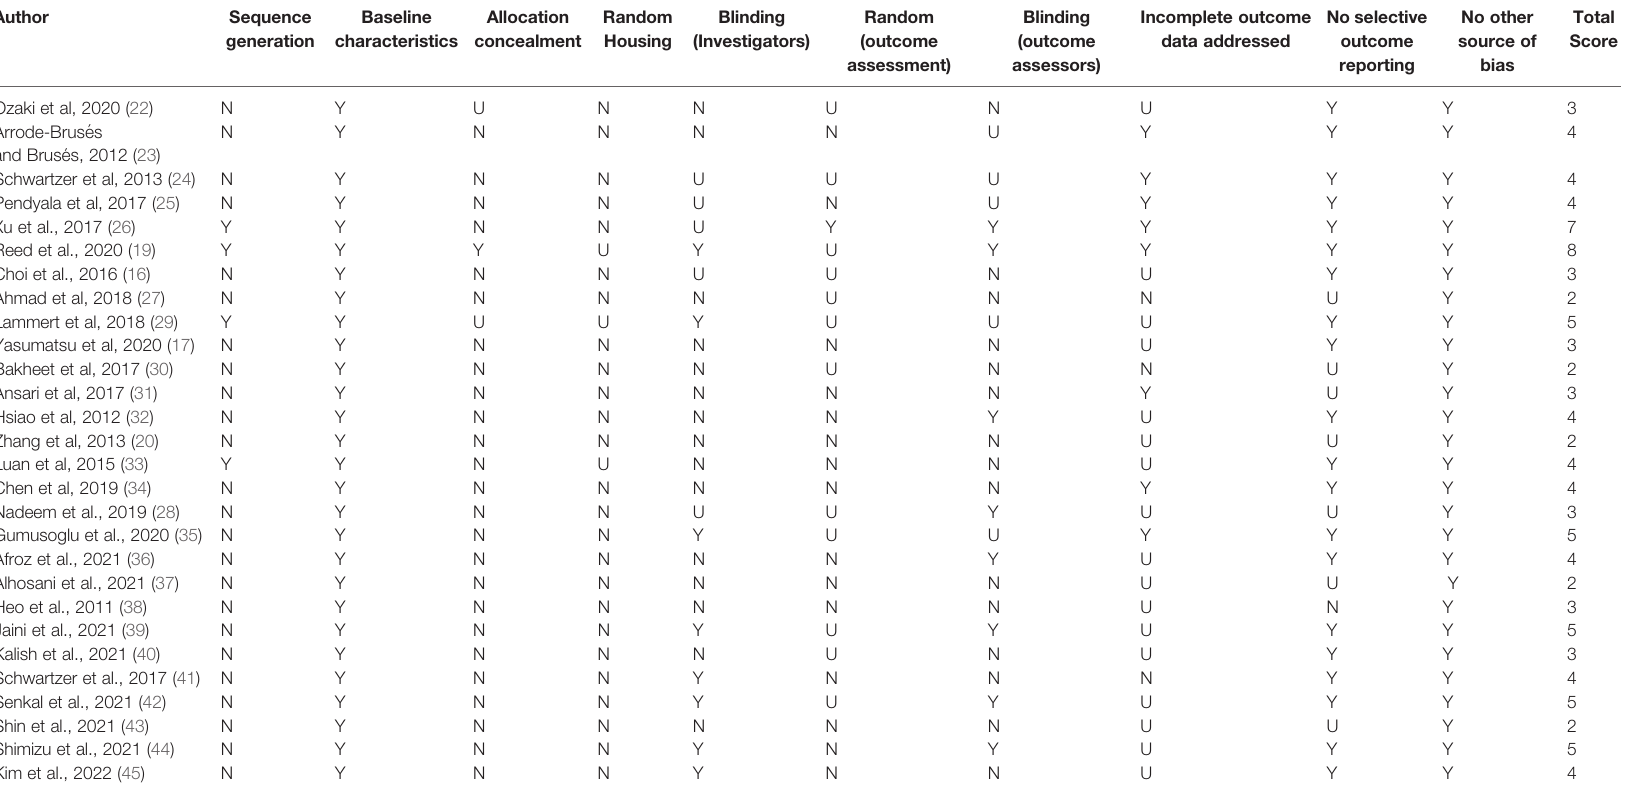
TABLE 2 | Systematic Review Centre for Laboratory animal Experimentation (SYRCLE) scale for risk of